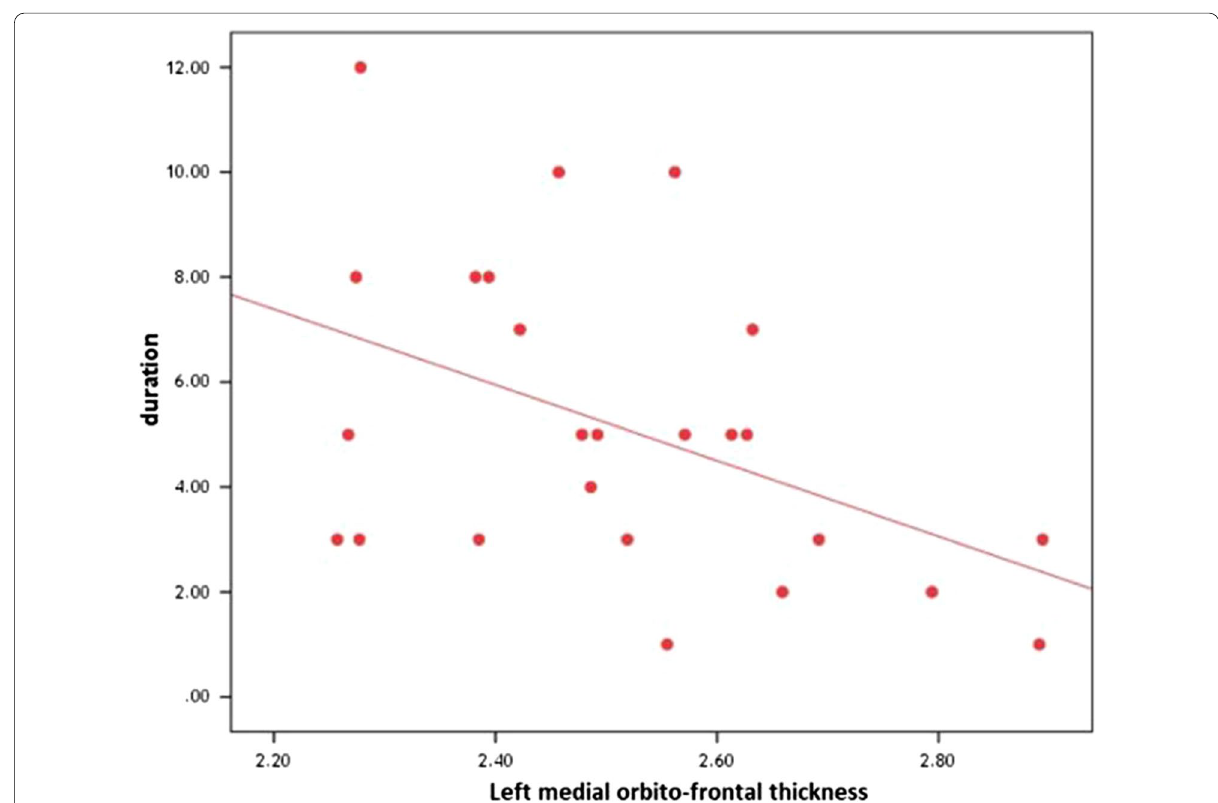
Fig. 5 Significant negative correlation between the disease duration and left medial orbitofrontal